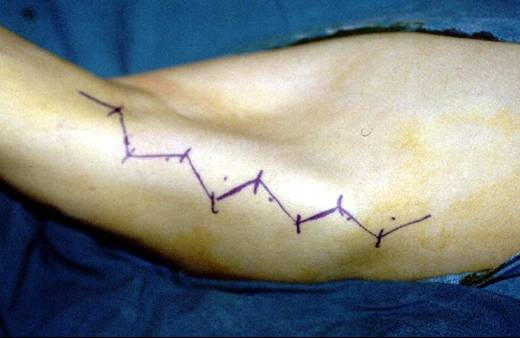
Operative incision. Posterior zigzag incision parallel to the lateral border of scapula is planned for preparing the conjoined tendon of latissimus dorsi and teres major.